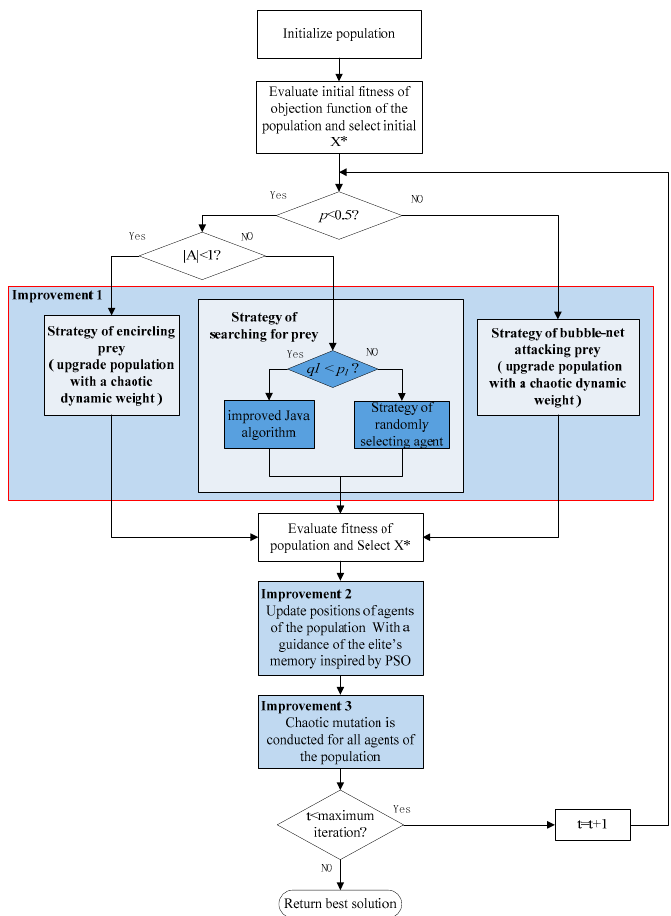
Figure 2. Improvement strategies in MSWOA.